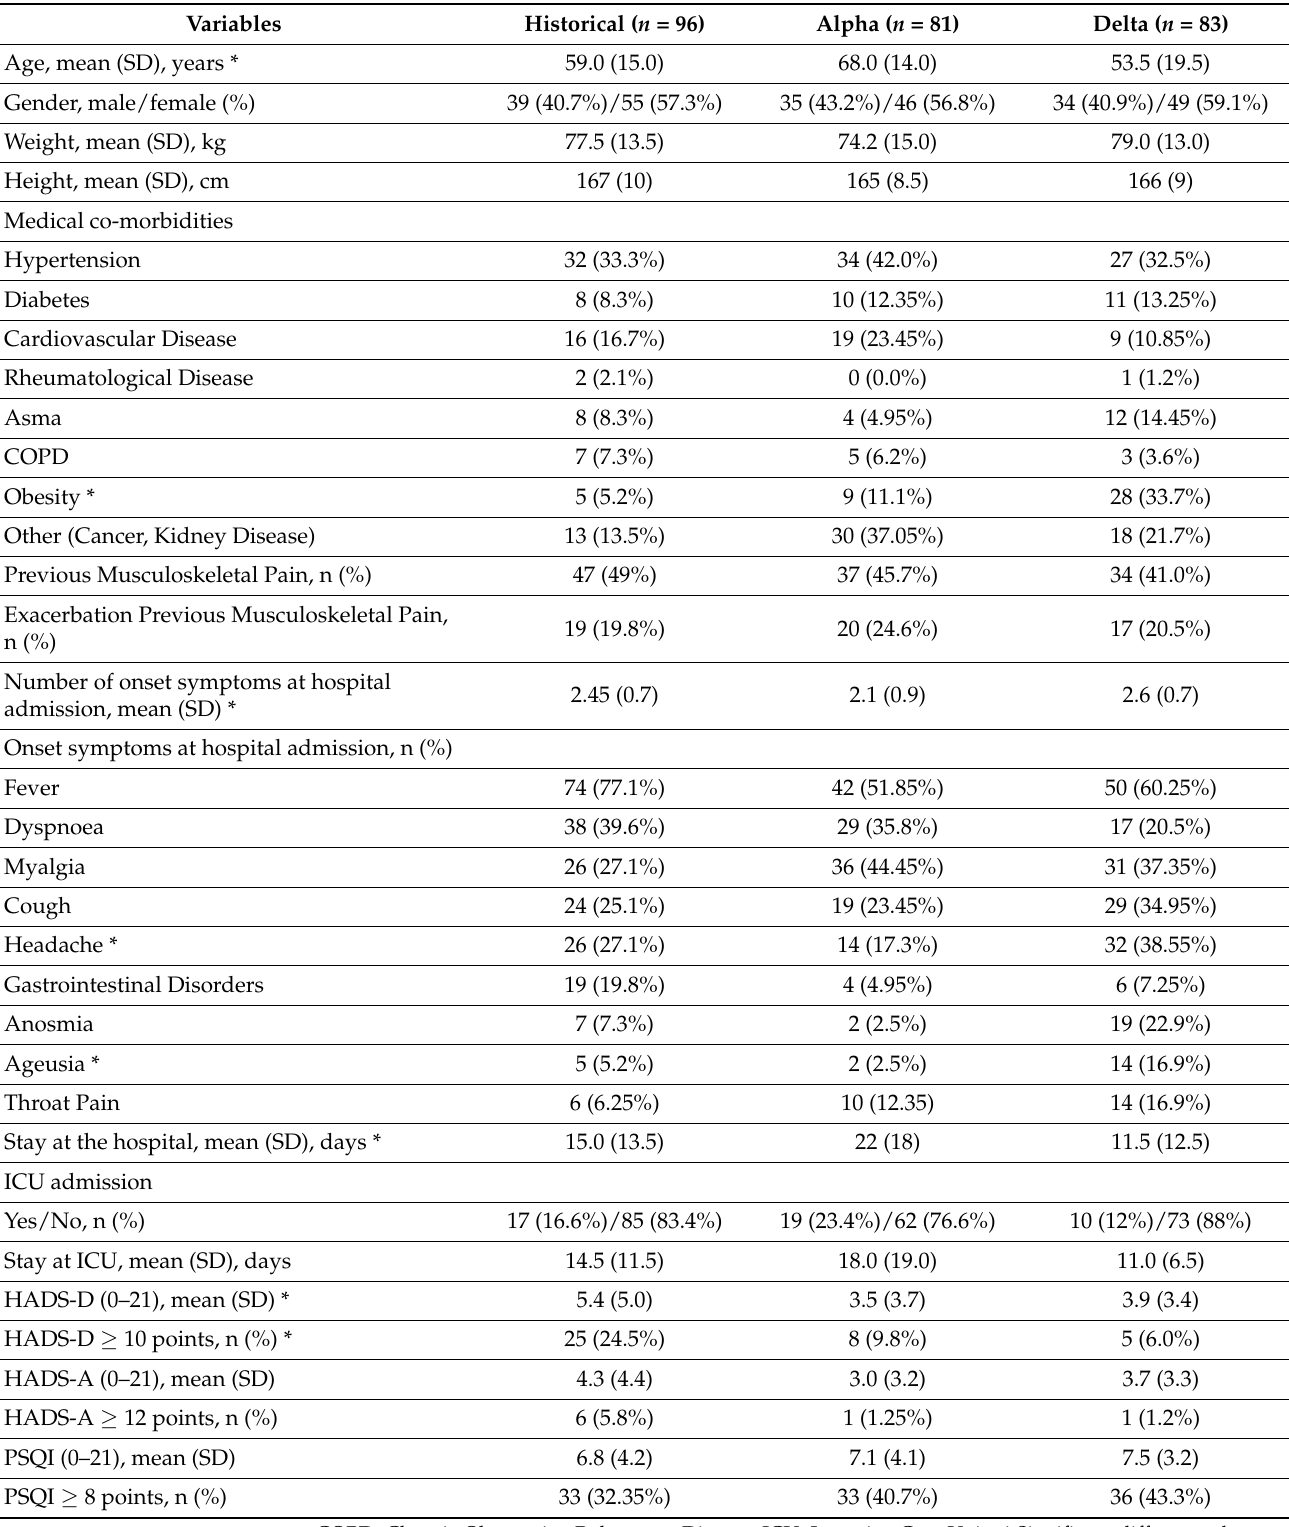
Table 1. Clinical and hospitalization data in individuals with musculoskeletal post-COVID pain by SARS-CoV-2